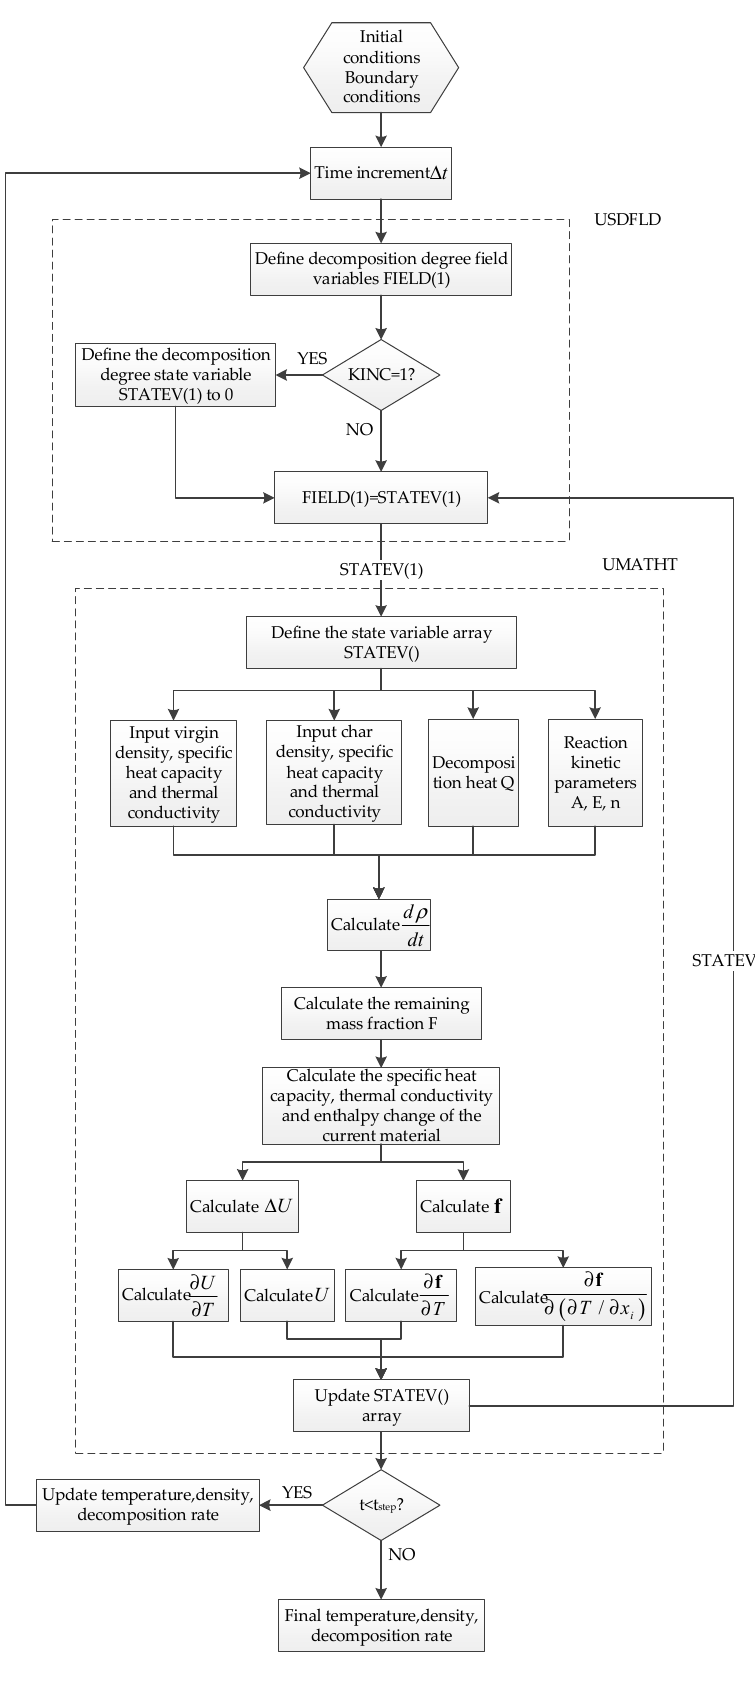
Figure 3. Flow chart of the thermal response calculation.